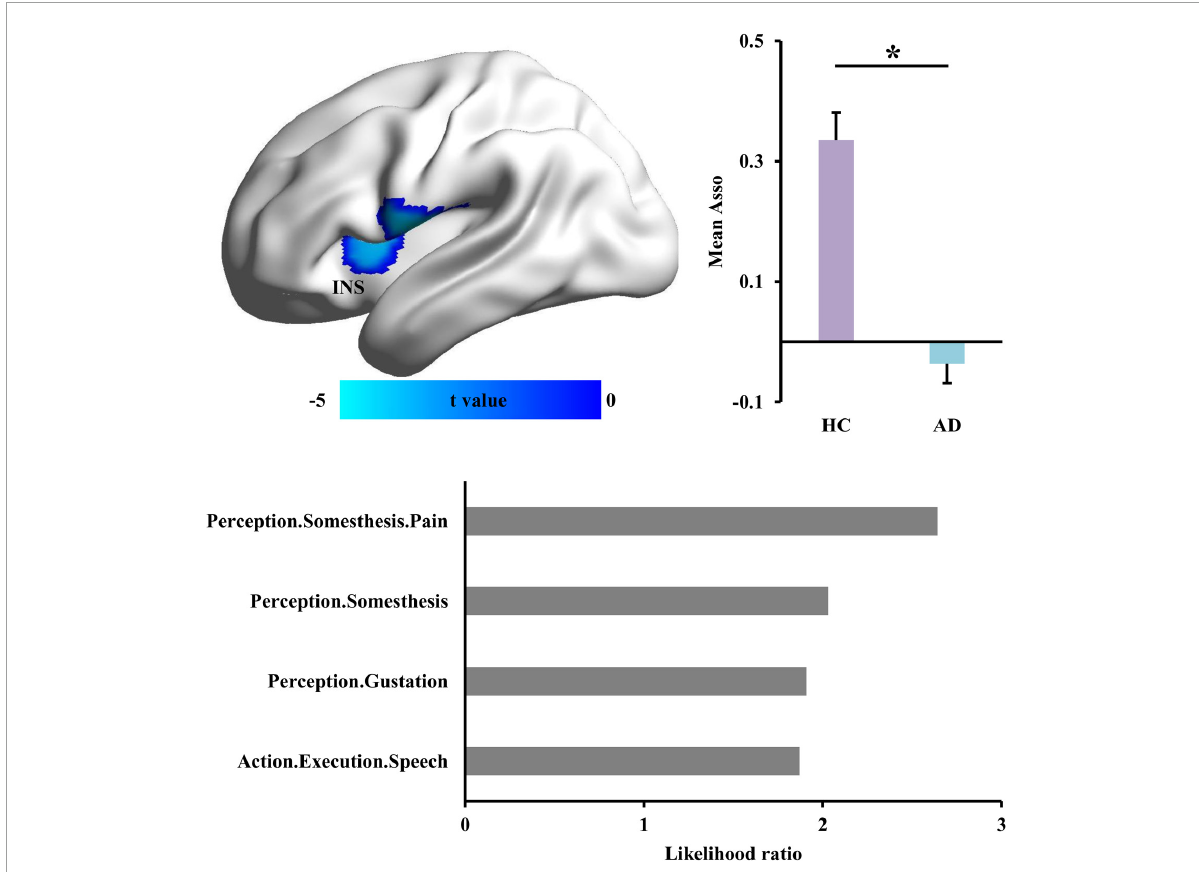
FIGURE1 Changed functional associations in Alzheimer’s disease (AD) patients. The whole brain voxel-wise association ability (Asso) mapping was applied to identify the difference in AD patients compared with healthy controls. The reduced Asso in left dorsal anterior insula (INS) was found in AD. The functional characterization of INS using BrainMap database found that this area is mainly involved in somesthesis perception and speech. *Represents a significant difference.